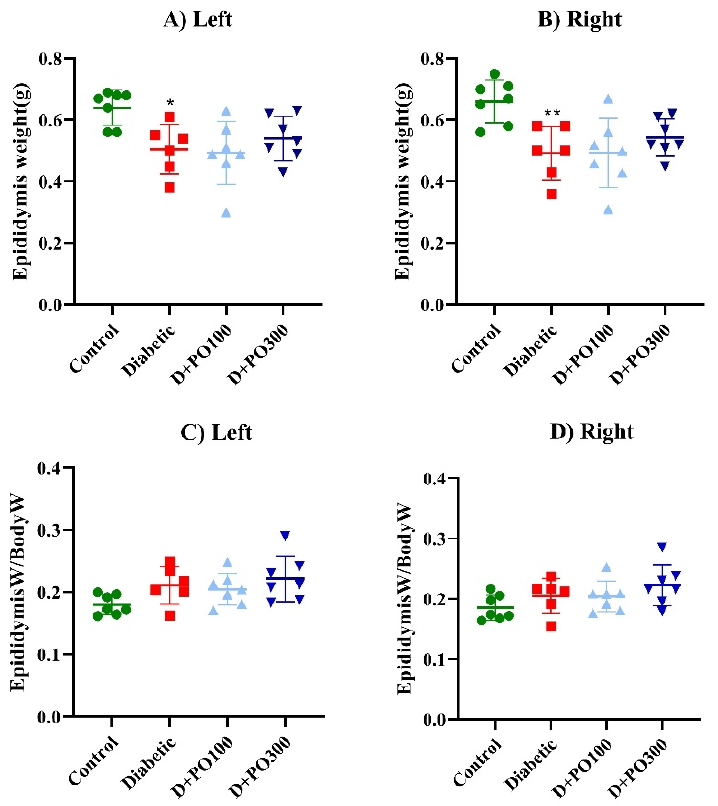
Figure 6. The effects of PO extract on ( A ) left and ( B ) right epididymis weight and ( C ) left and ( D ) right epididymis/body weight in diabetic rats. The data are presented as mean ± SD. A one-way ANOVA test was carried out with the following Tukey–Kramer’s post hoc test; * p < 0.05, ** p < 0.01 vs. control